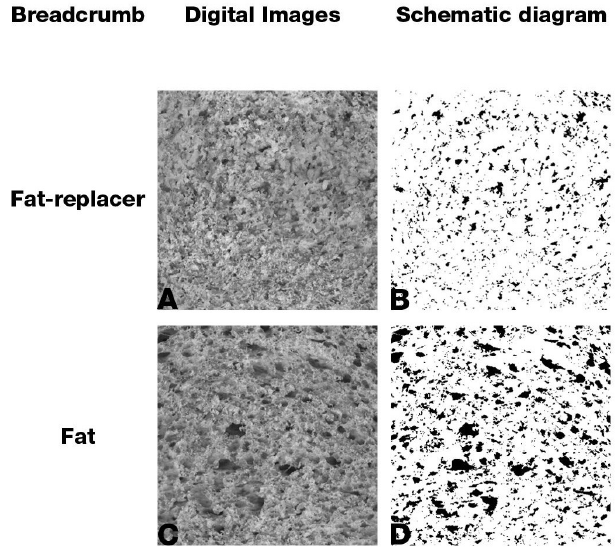
FIGURE 1 - Breadcrumb image analysis (40 mm x 40 mm crumb